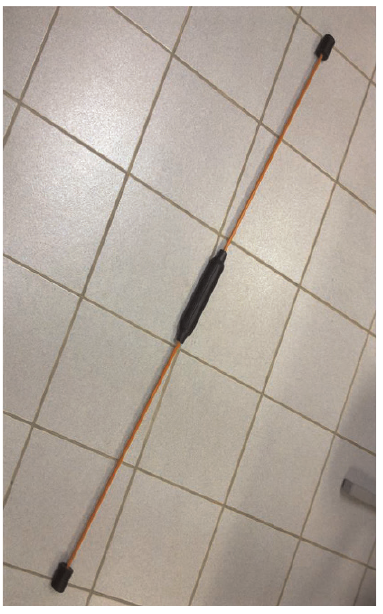
Figure 1 - Example of a flexible pole (Flexibar H ) used in our study.